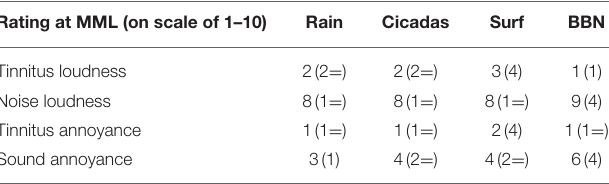
TABLE 3 | Ratings on a scale of 1–10 of tinnitus and sound loudness and annoyance at the MML of tinnitus. Rating at MML (on scale of 1–10)